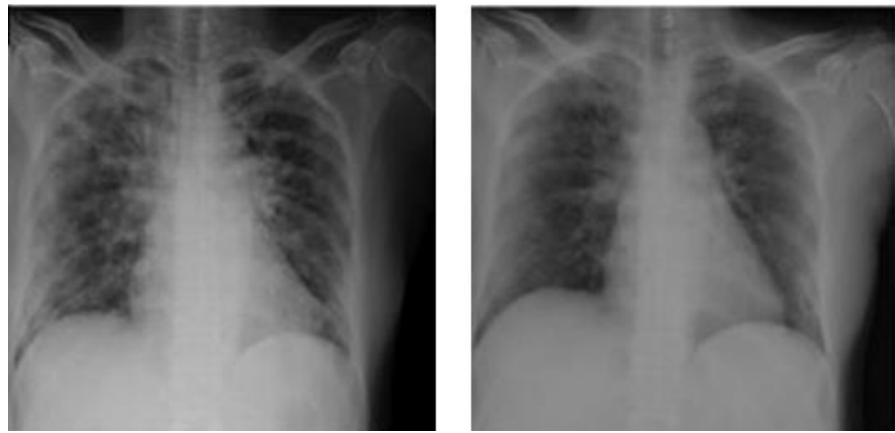
Figure 1. Ground glass opacities in CXR findings.